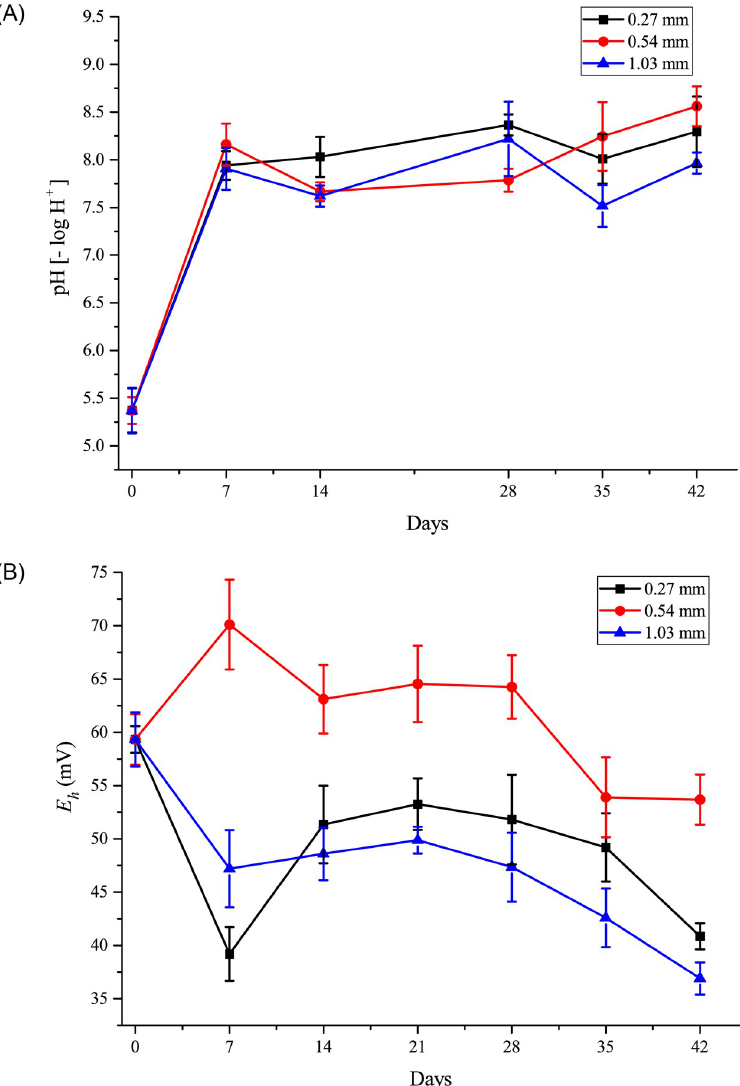
Fig 8. Effect of SRF films thickness on soil properties. A) pH [-log H + ] and B) redox potential ( E h ) changes over time after